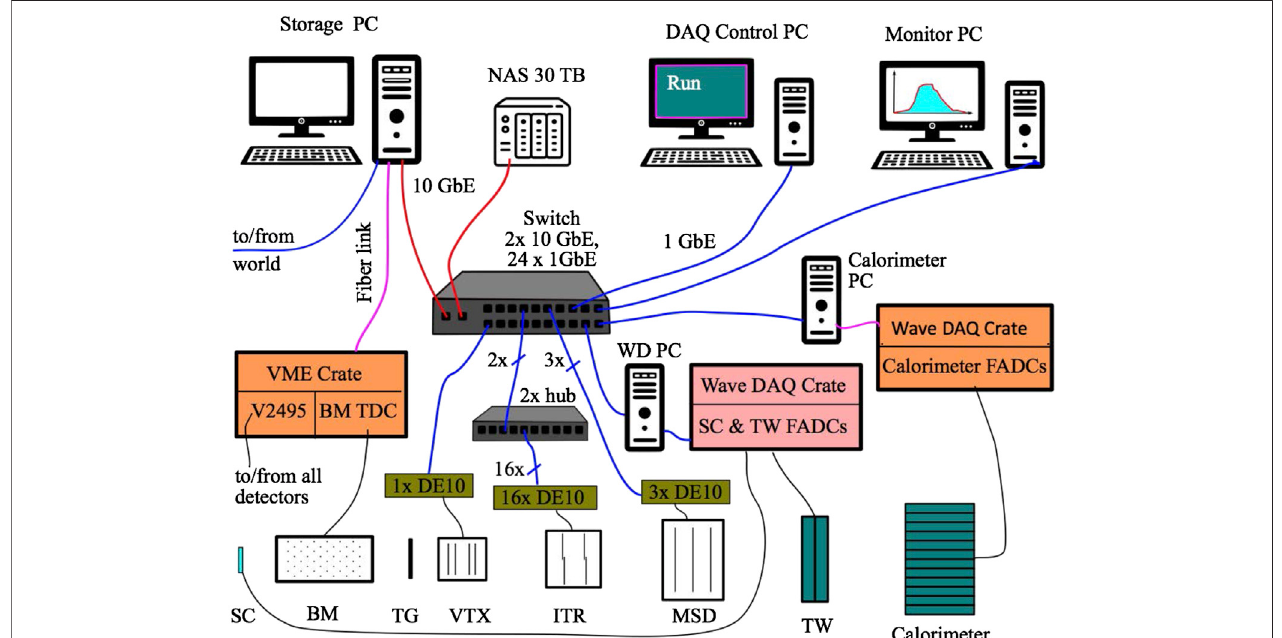
FIGURE 6 | DAQ logical